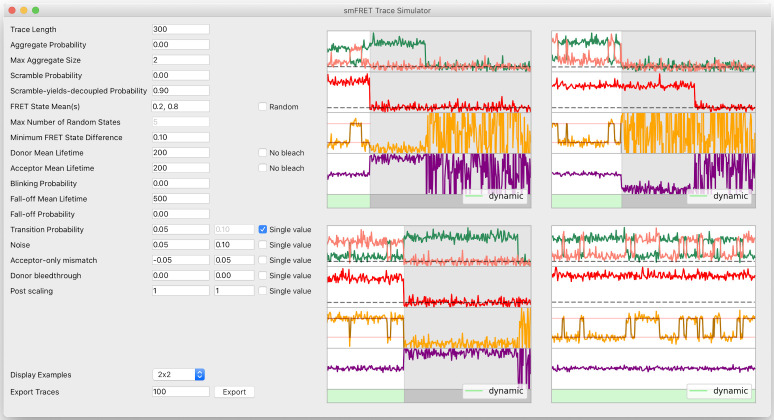
Trace simulator interface.To facilitate fast and easy experimentation of any kind on smFRET traces, the DeepFRET GUI includes a visual trace simulator with ground-truth labels associated with every trace. The traces can be exported to ASCII or DAT and used for all kinds of statistical procedures.